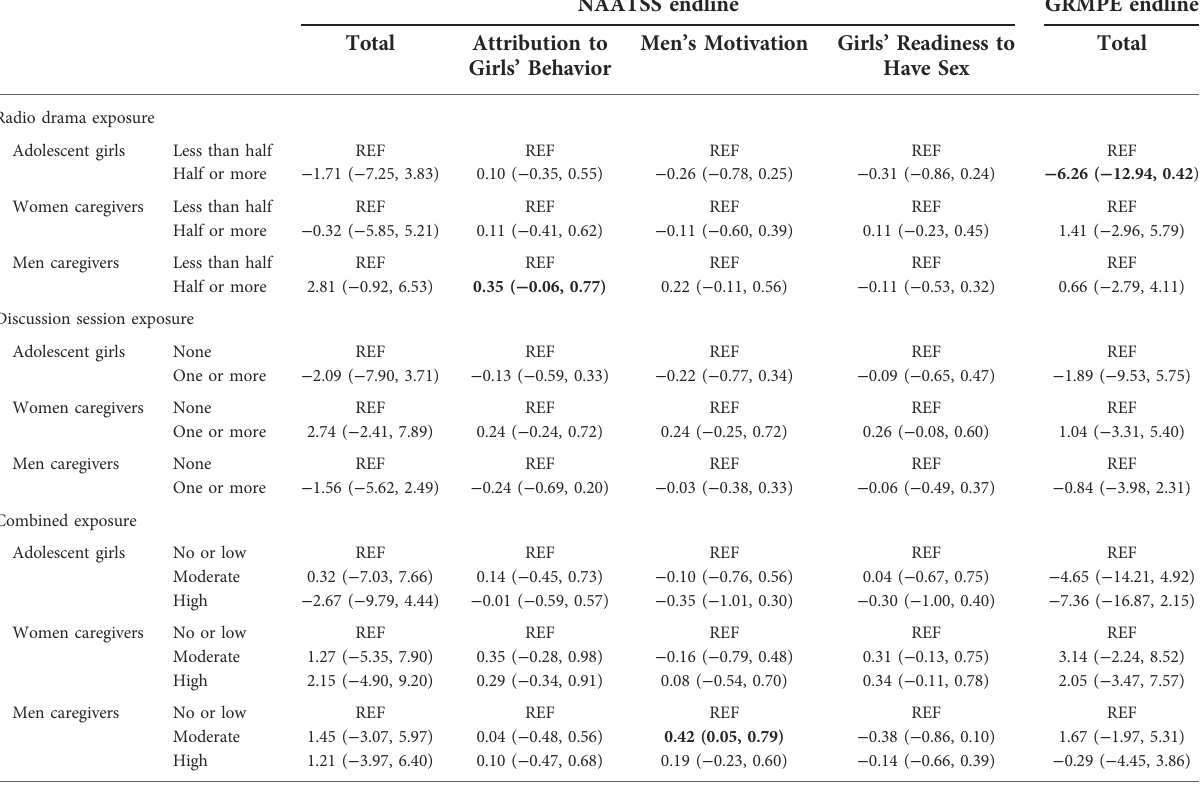
Bold values indicate p